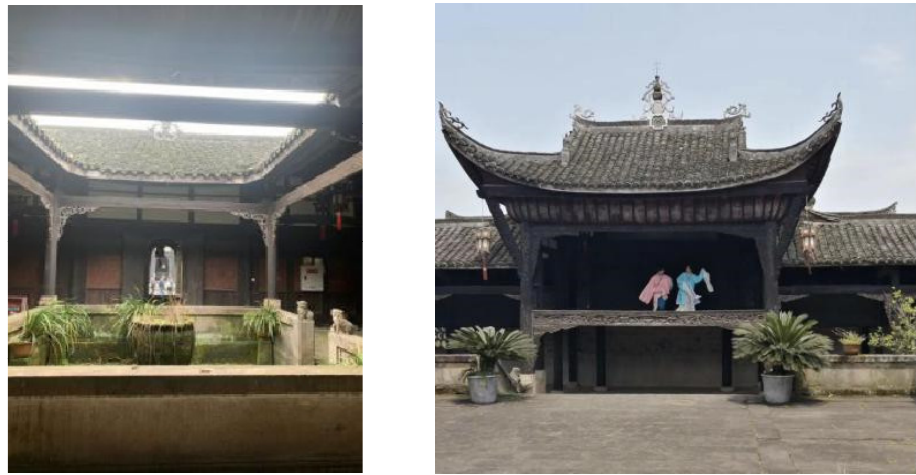
Figure 4. One of the courtyards ( left ) and the central opera stage ( right ) of Shilongjing Manor (source: Taken by the author).